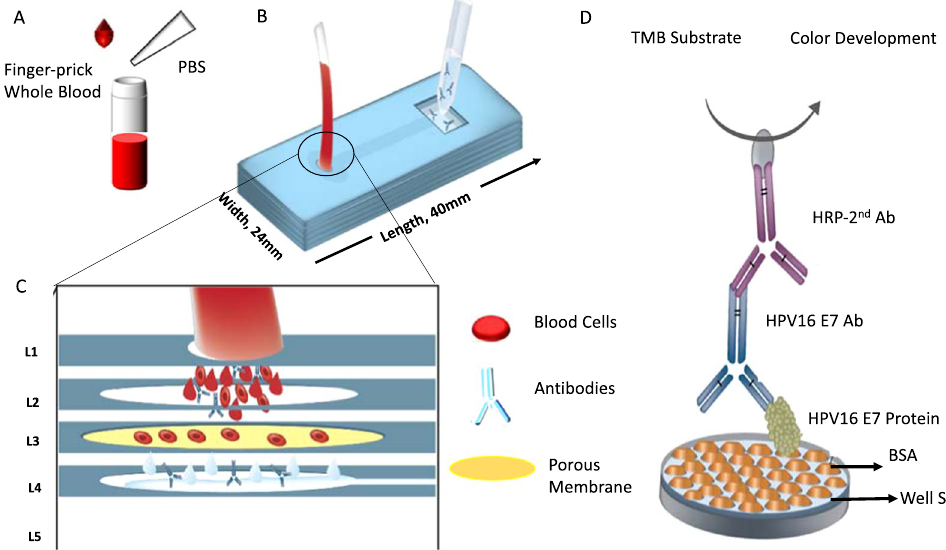
Figure 1. Design and construction of a small volume microfluidic device to selectively separate anti-HPV16 E7 antibodies and other proteins in plasma from the blood cells and their quantification by a customized immunoassay. ( A ) Finger prick volume of whole blood is collected and Initially only 15 µ L whole blood was used and diluted with PBS in 1:20. ( B ) DSA layers were used to assemble the PMMA layers. After chip construction steps, blood sample was applied through the inlet, and filtrate was then collected from the reservoir. Approximately 100 µ L of filtrate was collected. ( C ) A porous membrane is used to isolate the target antibodies from the whole blood by size-based filtration. Blood cells were retained on the membrane while plasma containing antibodies pass through. ( D ) Customized immunoassay was designed to detect anti- HPV16 E7 antibody from the filtered sample. Briefly, in the immunoassay, each well on 96-well plate was first coated with HPV16 E7 protein. Then, the filtered plasma sample containing anti-HPV16 E7 antibody (primary antibody) was applied to the wells. To generate a color development (blue to yellow), HRP-conjugated secondary antibody was coupled with TMB solution. The absorbance value at 450 nm was determined as the signal unit of customized immunoassay. Image courtesy of “Amy Thomas” for sub-figures ( B , C and D